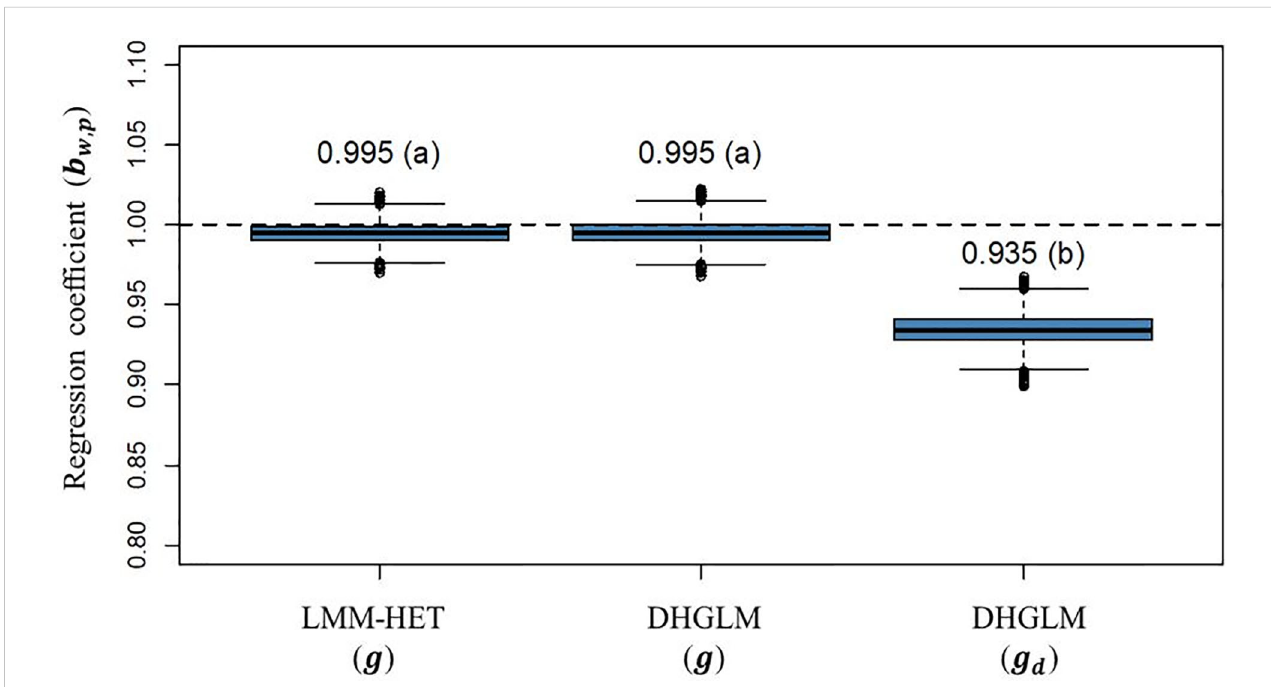
FIGURE 6 Boxplot of bootstrap distribution for the slope of the regression of additive genetic values obtained with whole phenotypic information on additive values obtained with partial phenotypic information ( b w , p ) in a leave-one-line-out (LOO) cross-validation. LMM-HET: linear mixed model allowing heteroscedasticity of residual variance for the different environments. DHGLM: double hierarchical generalized linear model. g : predicted additive genetic values for corrected phenotypes ( y c ). g d : predicted additive genetic values for dispersion variable ( y d ). The letter above the bar denotes signi fi cant differences between models in a t-test ( P-value < 0.01). The black dashed line represents a regression coef fi cient of one, where no under or over-dispersion is